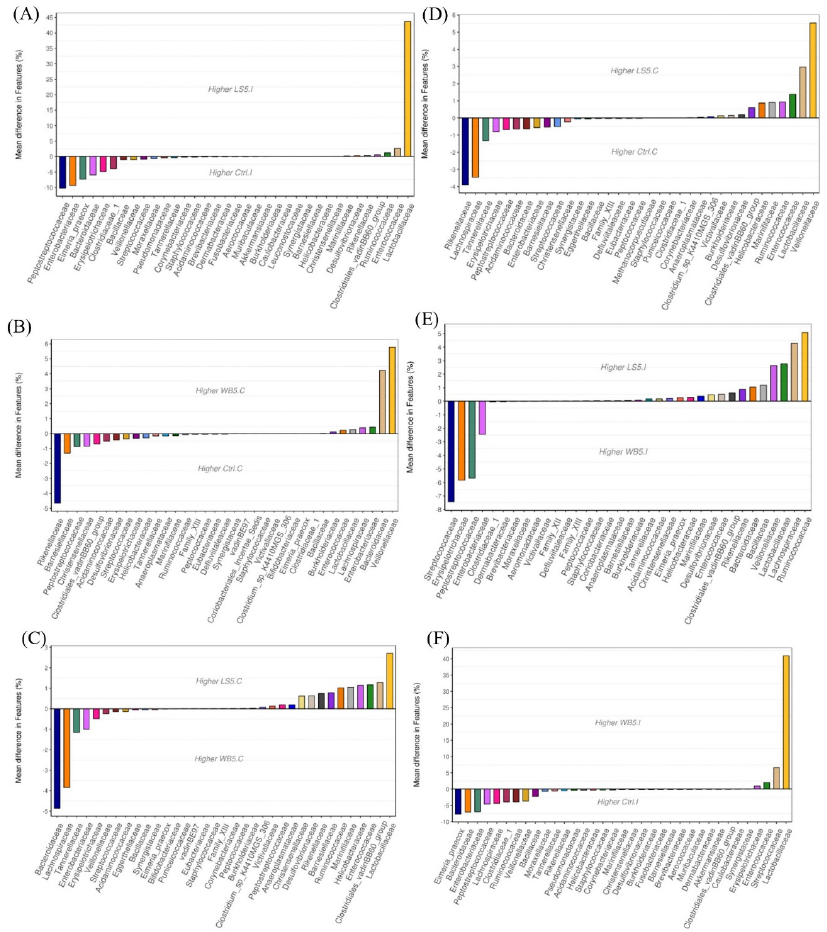
Figure 3. Mean differences in the microbiota composition at the genus level of 35-day-old broilers. Ileum of LS vs. Ctrl ( A ); WB vs. Ctrl ( B ); LS vs. WB ( C ); Cecum of LS vs. Ctrl ( D ); WB vs. Ctrl ( E ); LS vs. WB ( F ). Ctrl: control group; WB5: broilers supplemented with 5% wheat bran; LS5: broilers supplemented with 5% Laetiporus sulphureus wheat bran. Results are means of six samples obtained from the individual birds of each of the control and experimental groups.